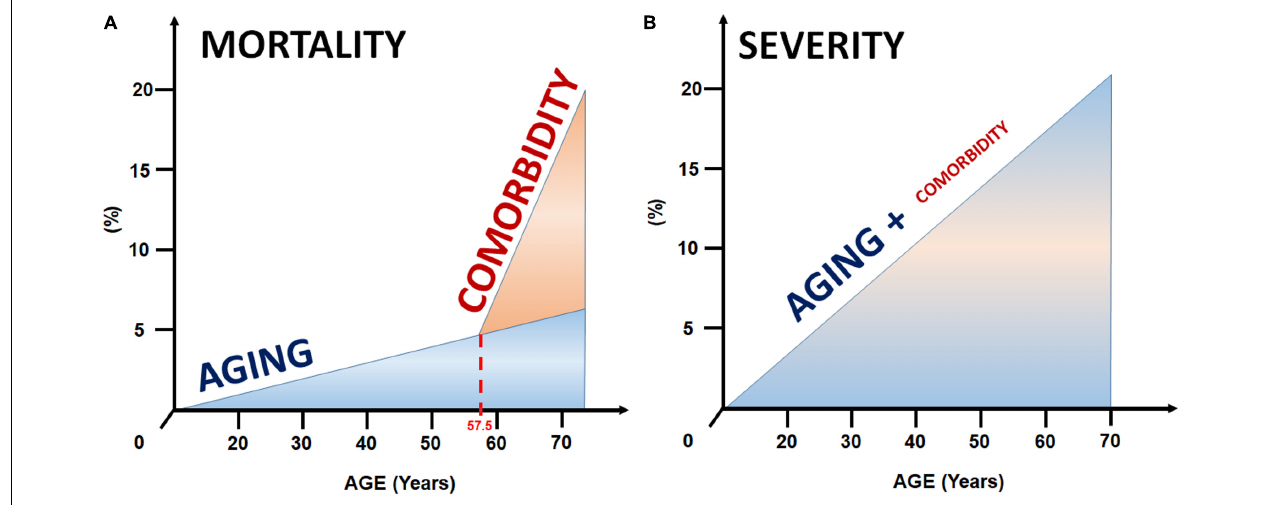
FIGURE 5 | Model for the joint effect of aging and comorbidities on mortality and severity. (A) The excess in mortality in the elderly is likely to be explained by the increment in comorbidities with aging. (B) In contrast, age seems to be the strongest predictor of the severity of AP, whereas comorbidities have a less prominent